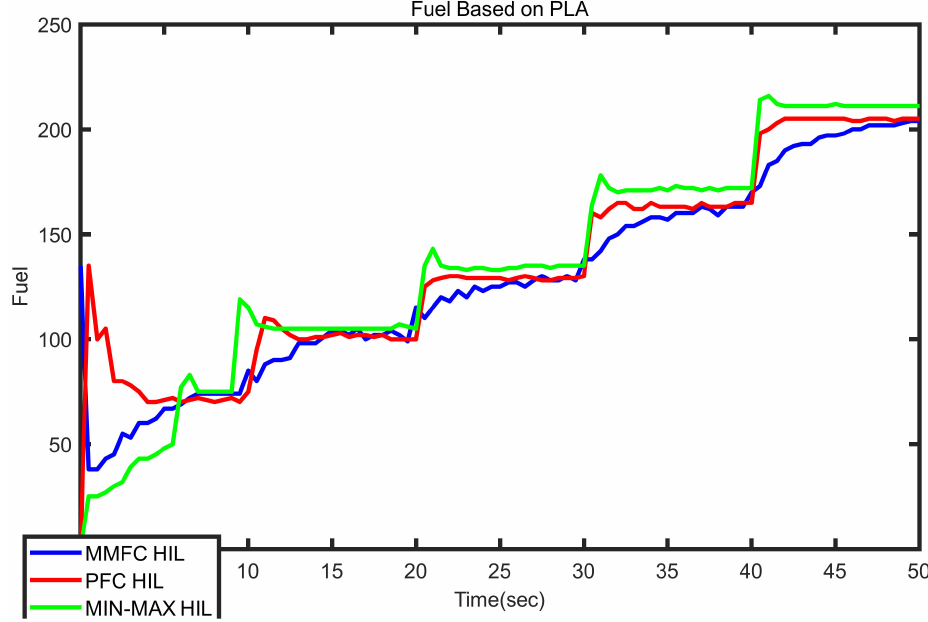
Figure 23. Fuel consumption comparison between PFC, MMFC and the MIN–MAX controller in the HIL